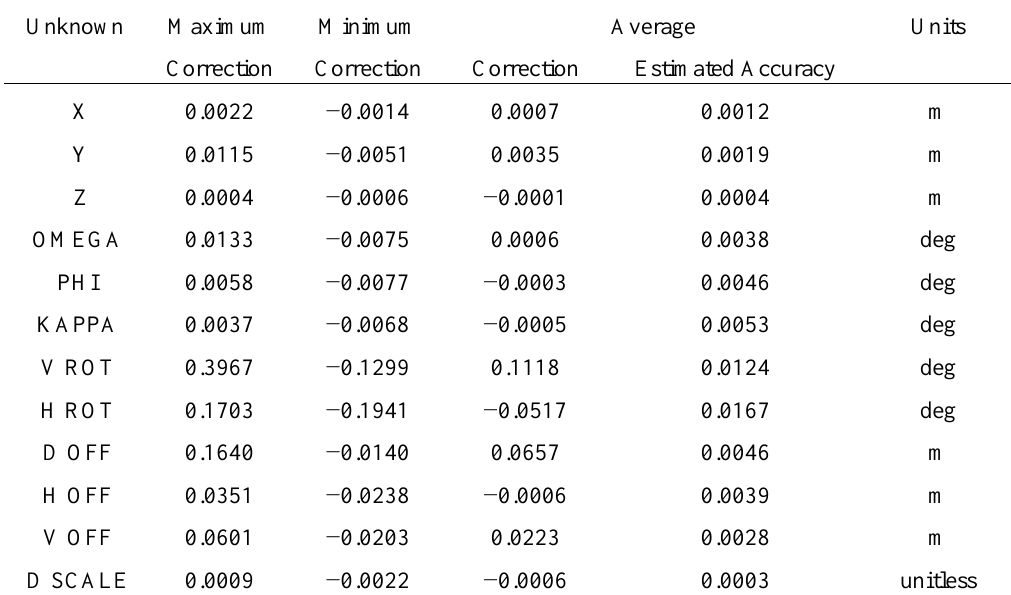
Table 6. Maximum, Minimum and Average Correction and Accuracy Estimates for Unknown